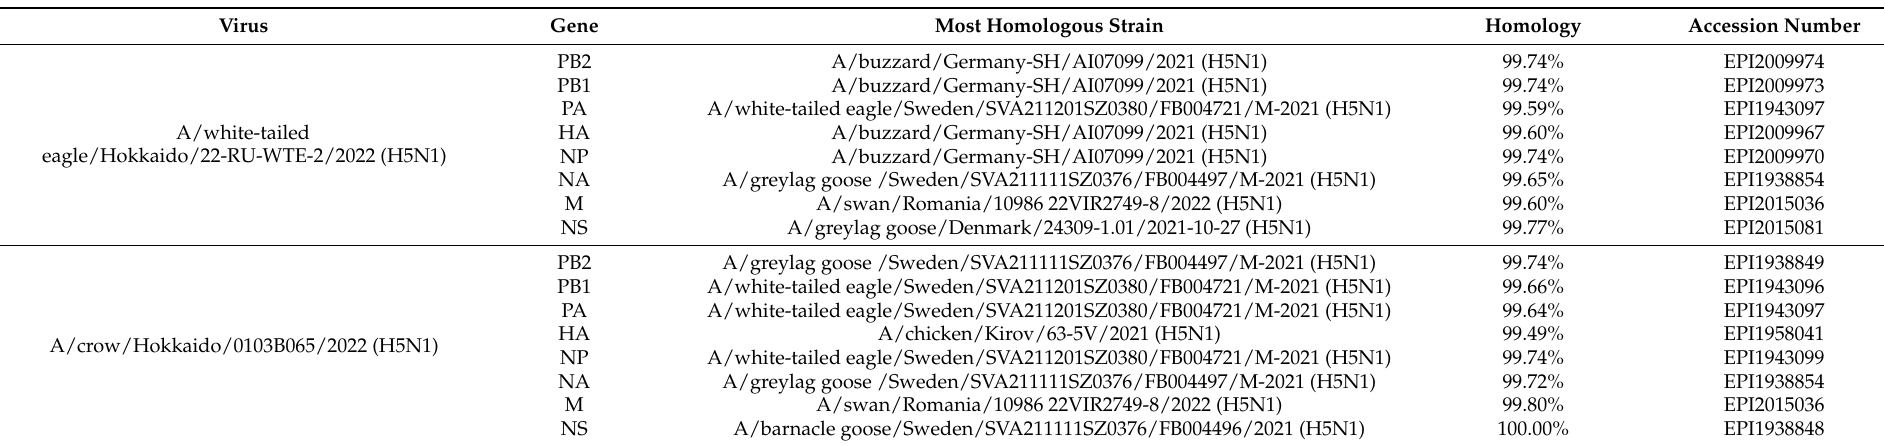
Table 1. BLAST search results of nucleotide sequence of two representative strains in the GISAID